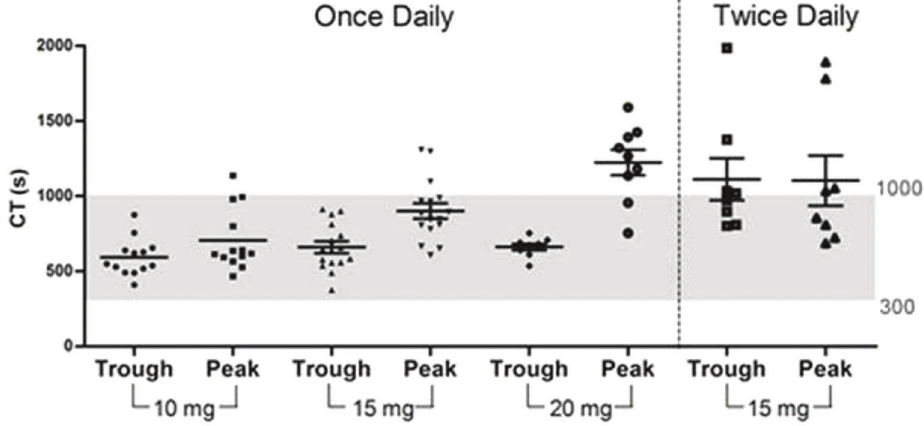
Figure 1. Clotting times (CT) in the groups